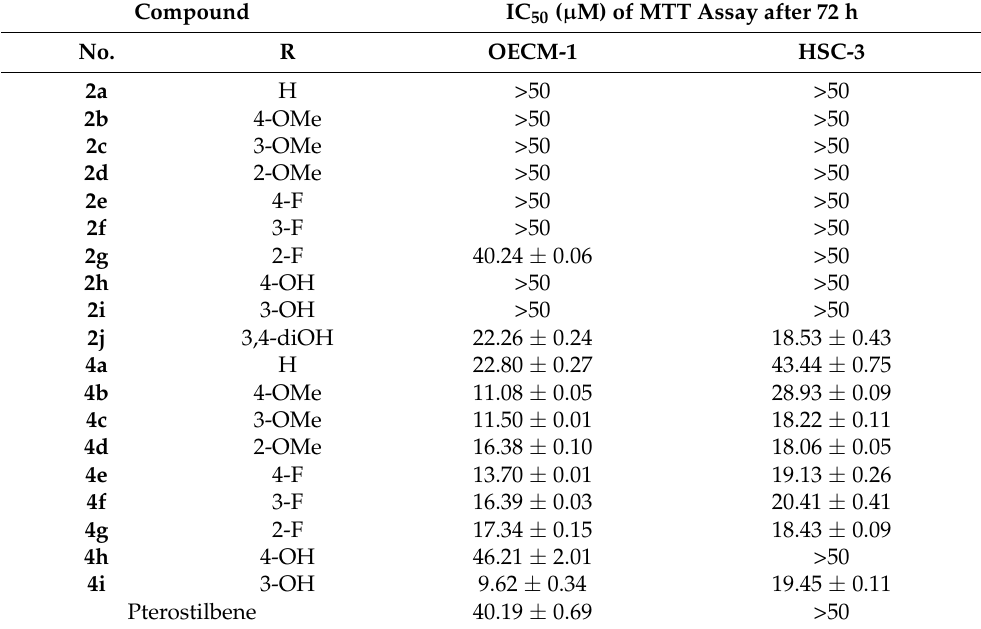
Table 1. In vitro IC 50 values ( µ M) of compound 2 , 4 series in OSCC lines.